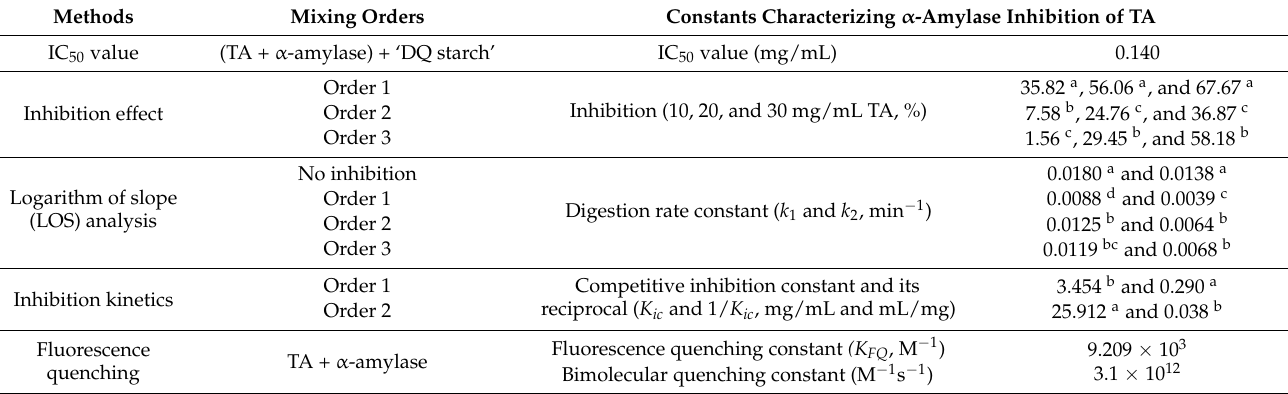
Table 1. The methods and corresponding constants that characterize α -amylase inhibition of TA for different mixing orders of the inhibitor, enzyme, and